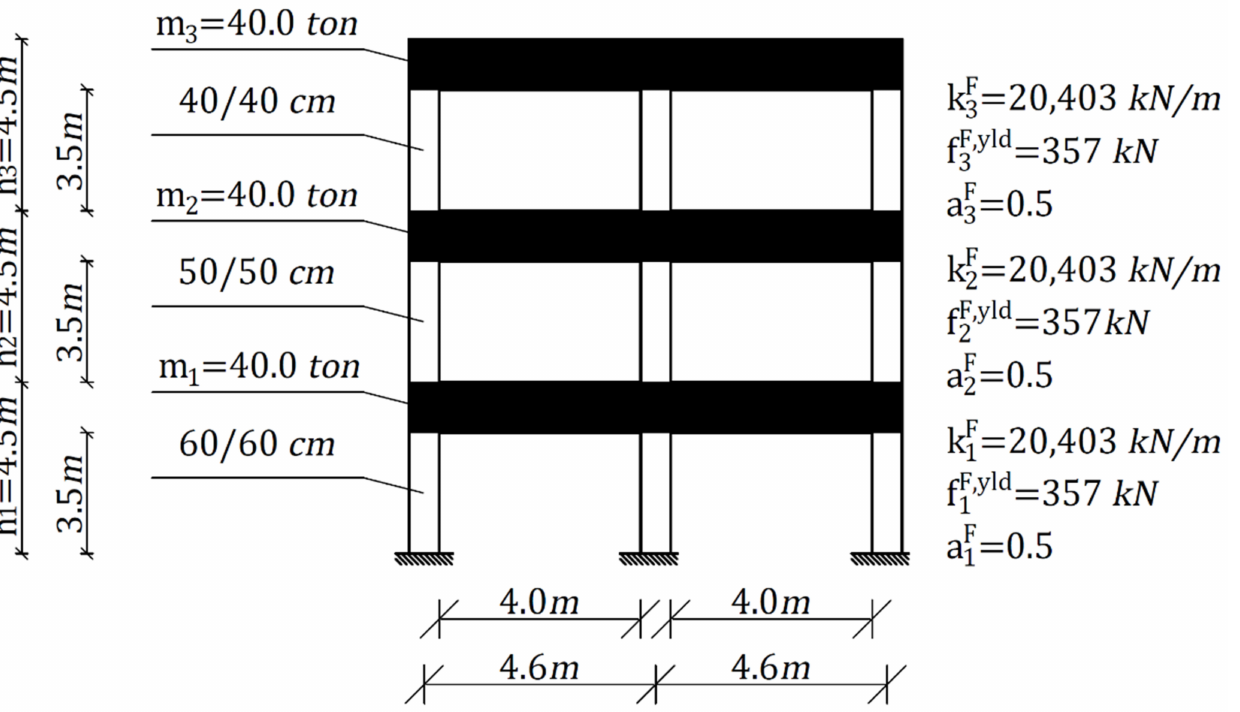
Figure 5. The bare three-story rigid frame